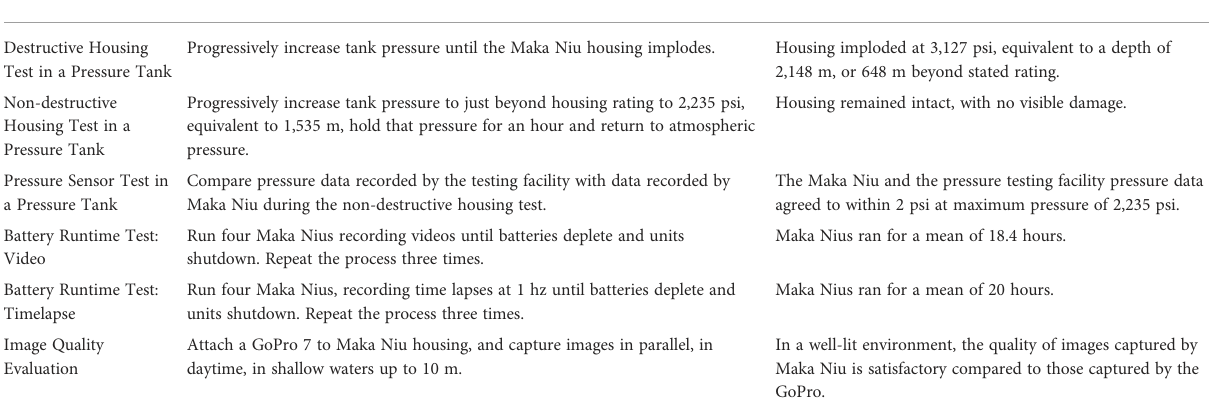
TABLE 1 Test Procedure Result